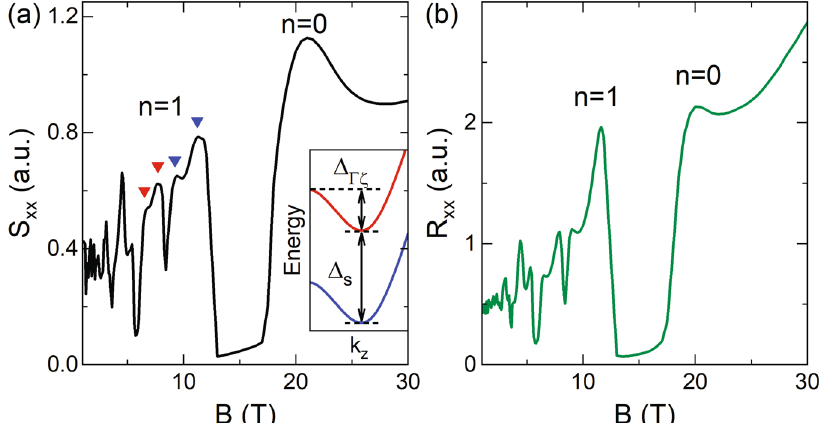
Fig. 4 Calculated magneto-resistance and magneto-thermopower. Calculated a S xx and b R xx as a function of magnetic fi eld. To demonstrate the four-fold splitting, a relatively small scattering rate of 0.6 meV is used in the calculation. Other parameters are listed in Supplementary Note 4. The red and blue down-triangles mark the four-fold splitting of the n = 1 peak in S xx , following the assignment in Fig. 3b. Inset to a illustrates the band alignment within the n = 1 LL, according to assignment (1) described in the main